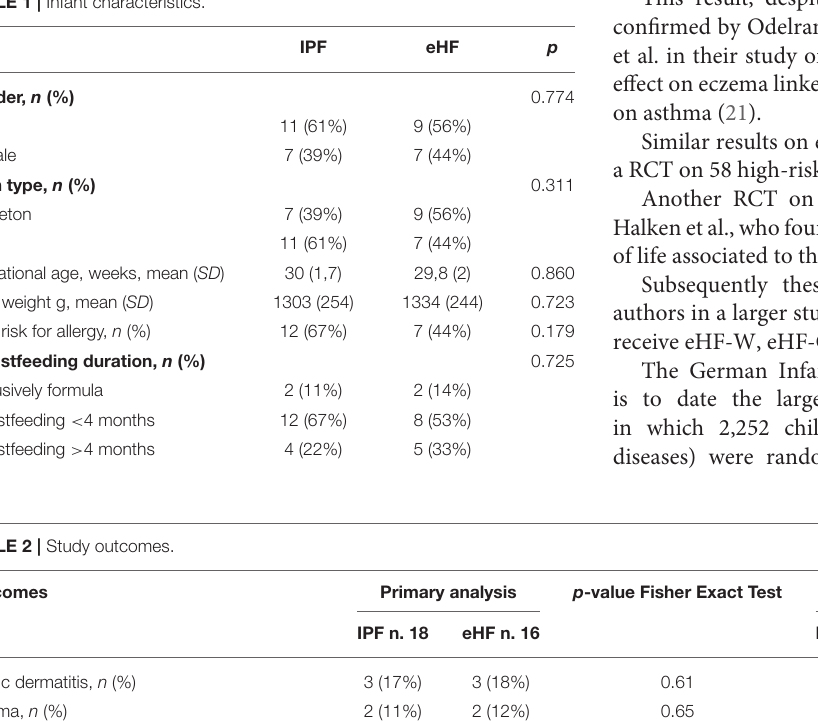
TABLE 1 | Infant characteristics.